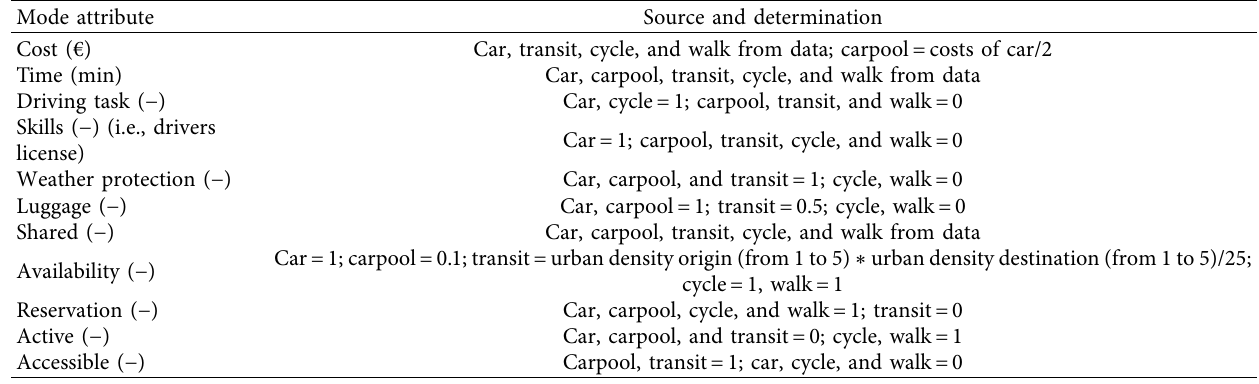
Table 3: Mode attributes based on OViN [33] and assumptions.